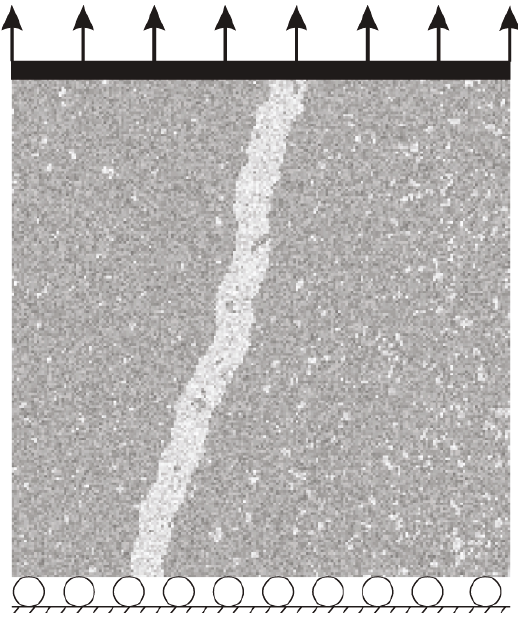
Figure 10: Model loading